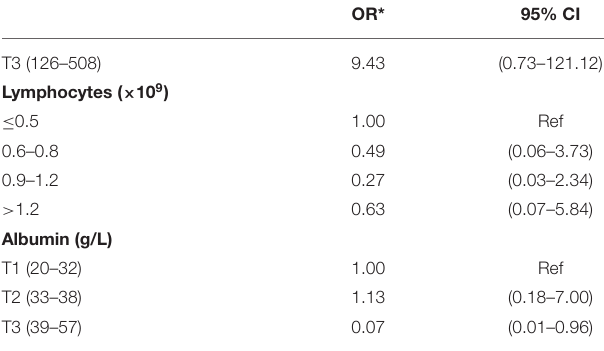
TABLE 4 | Odds Ratios and 95% confidence intervals for COVID-19 severity in cancer